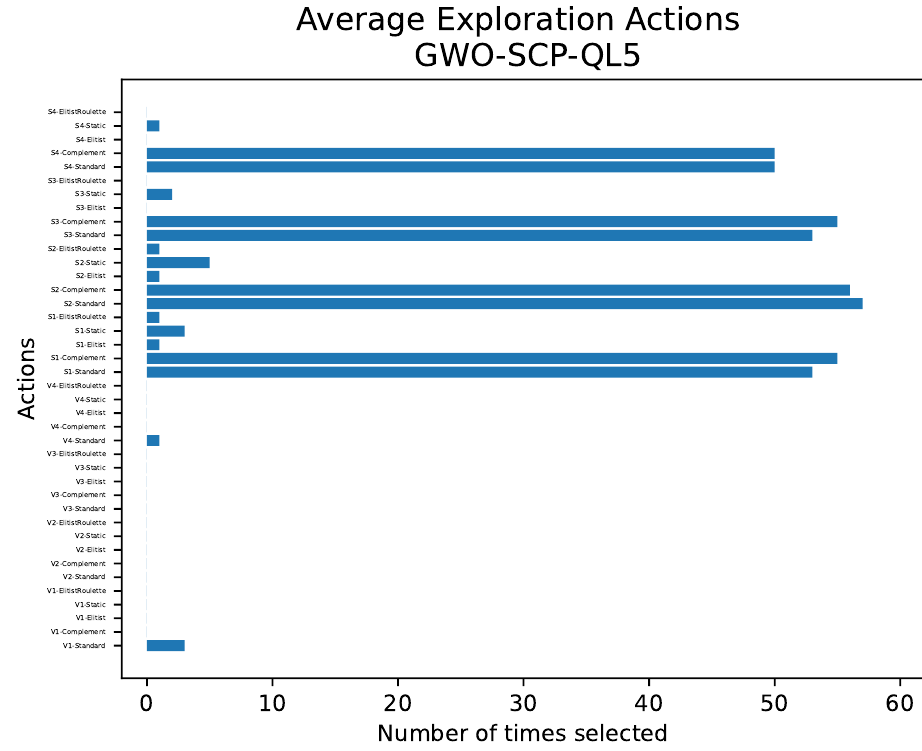
Figure 11. GWO-QL5—The average number of actions in the exploration